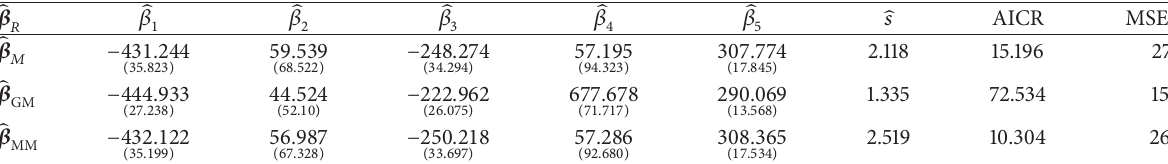
Table 3: The parameter estimates of the robust estimators.